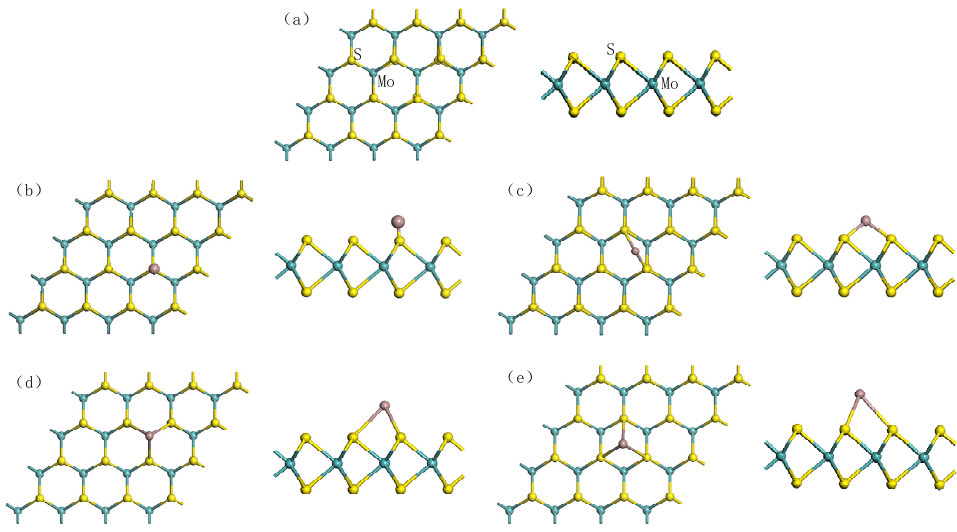
Figure 2. Structure of ( a ) pure MoS 2 , ( b ) T S site, ( c ) B S-S site, ( d ) T Mo site, ( e ) T H site.